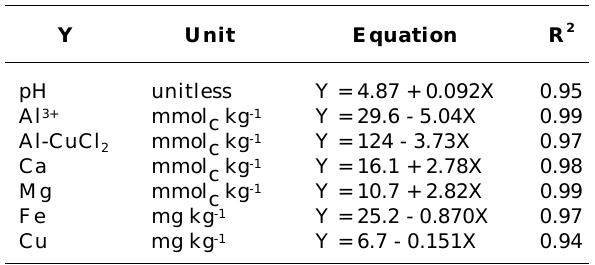
Table 3. Regression equations (1) and coefficients of determination between some soil characte- ristics (2) (Y) and liming rate (X, in t ha -1 ) in an Oxisol of Lages, Southern Brazil.